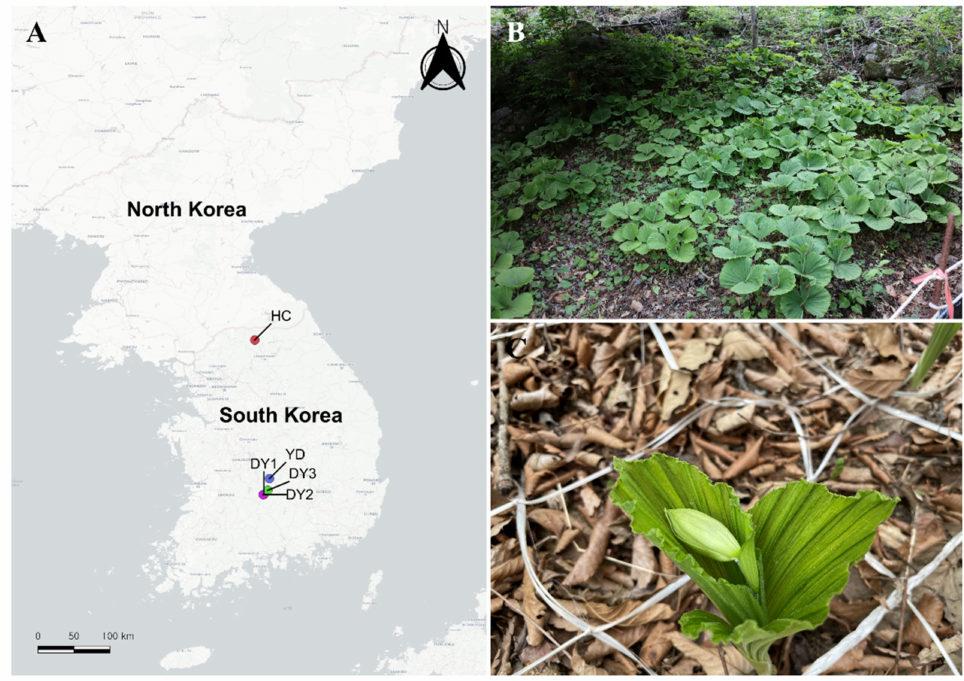
Figure 1. Sampled populations of Cypripedium japonicum in Korea ( A ), DY1, DY2, and DY3 (Mt. Deokyu population), YD (Youngdong-gun population), HC (Hwacheon-gun population), detailed information is given in Table 1. ( B ) Natural habitat of Hwacheon-gun population (HC), ( C ) Habit, unopened flower bud for meiotic